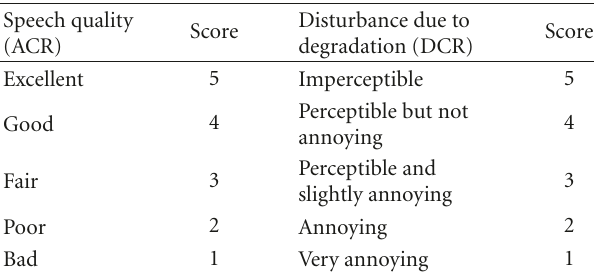
Table 1: Opinion scales defined by the ACR (absolute category rating) method (left) and the DCR (degradation category rating) method